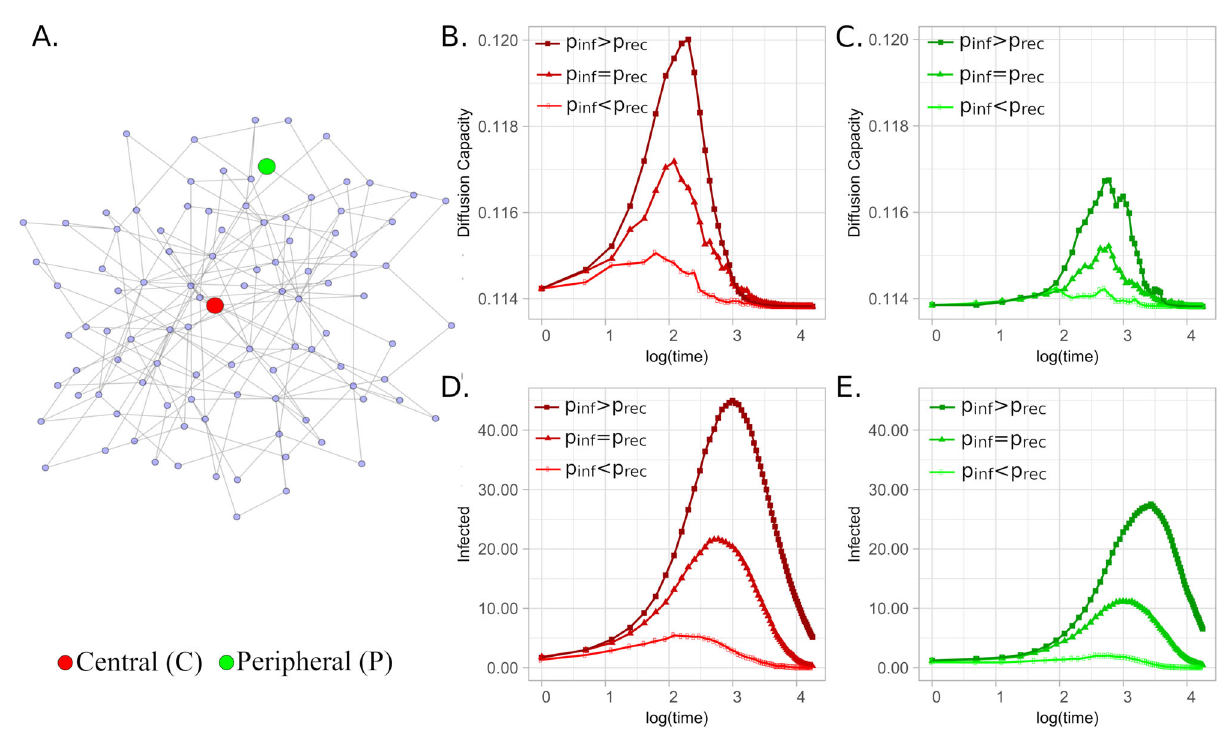
D , E depicttheevolutionofthenumberofinfectionsrespectively.All fi guresshow mean values of 100 realization considering a constant p inf =0.1 and p rec =0.05,0.10and0.20.